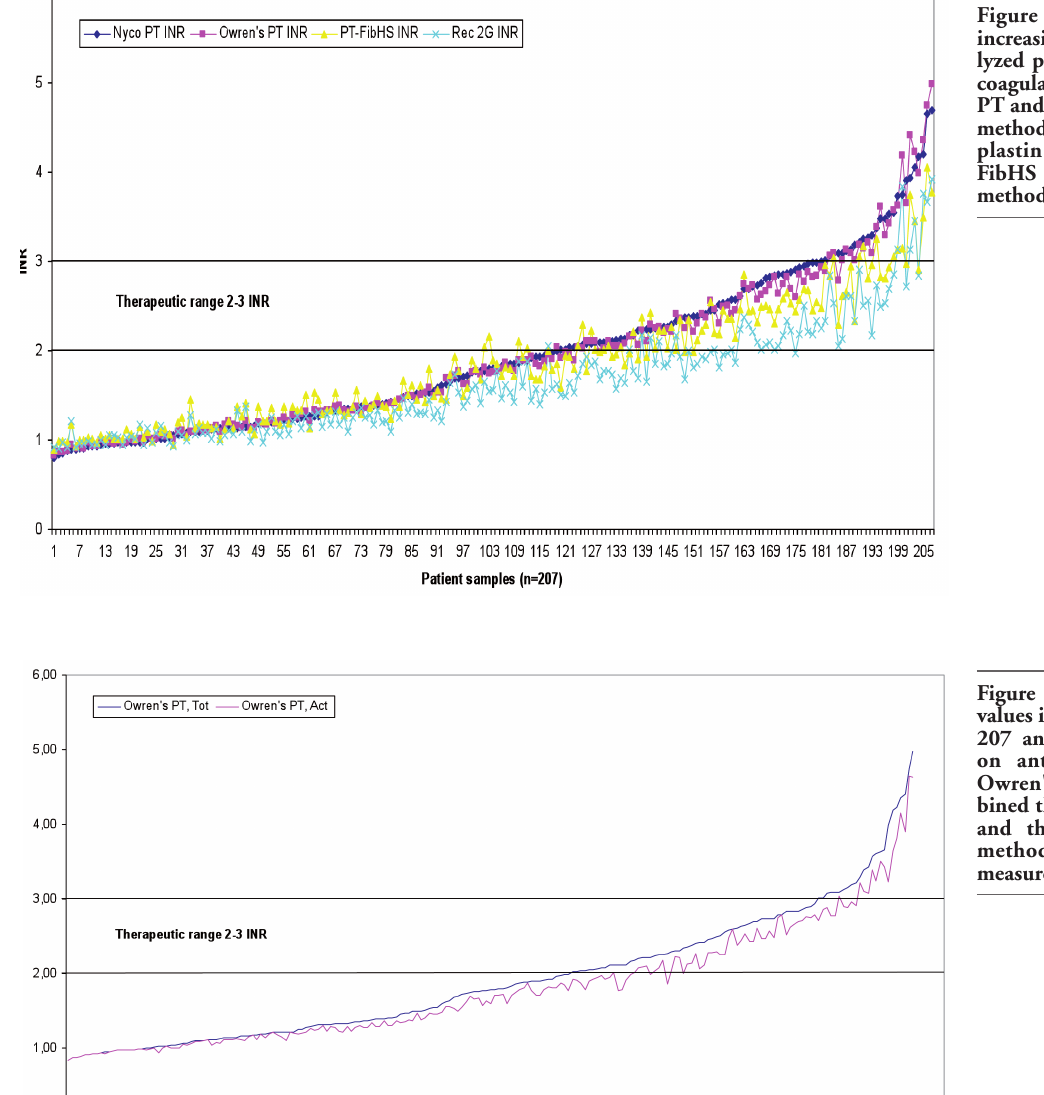
Figure 1. INR values in increasing order from 207 ana- lyzed patient samples on anti- coagulation therapy. Nycotest PT and Owren's PT are Owren methods (combined thrombo- plastin reagent), and PT- FibHS and Rec 2G are Quick methods.